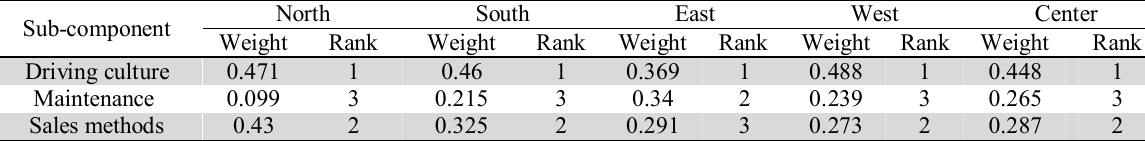
The summary of ranking of cultural factors based on ANP method Sub-component Driving